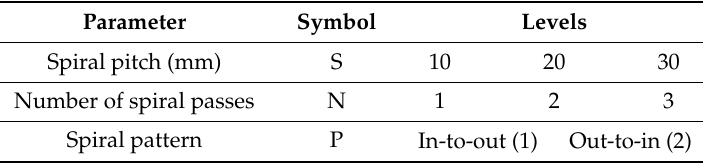
Table 4. The levels of laser formation process